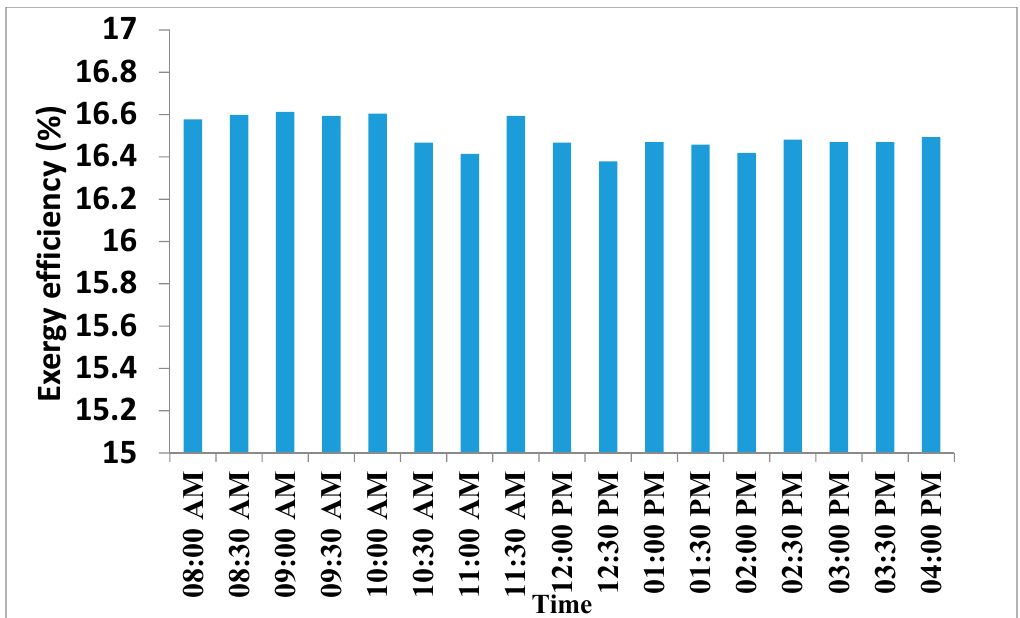
Figure 8. Variation of exergy efficiency of PVT system with